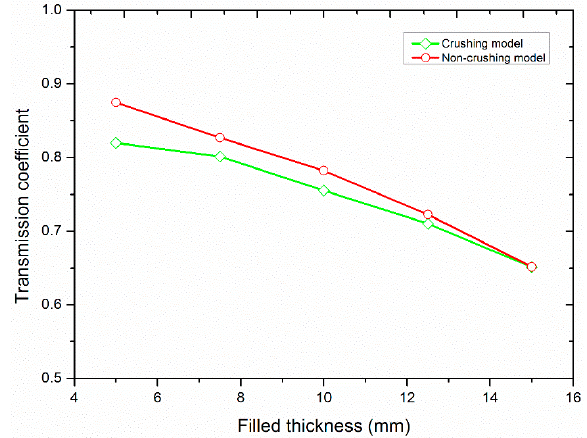
Figure 13. The variation of the transmission coefficient with the filled thickness.